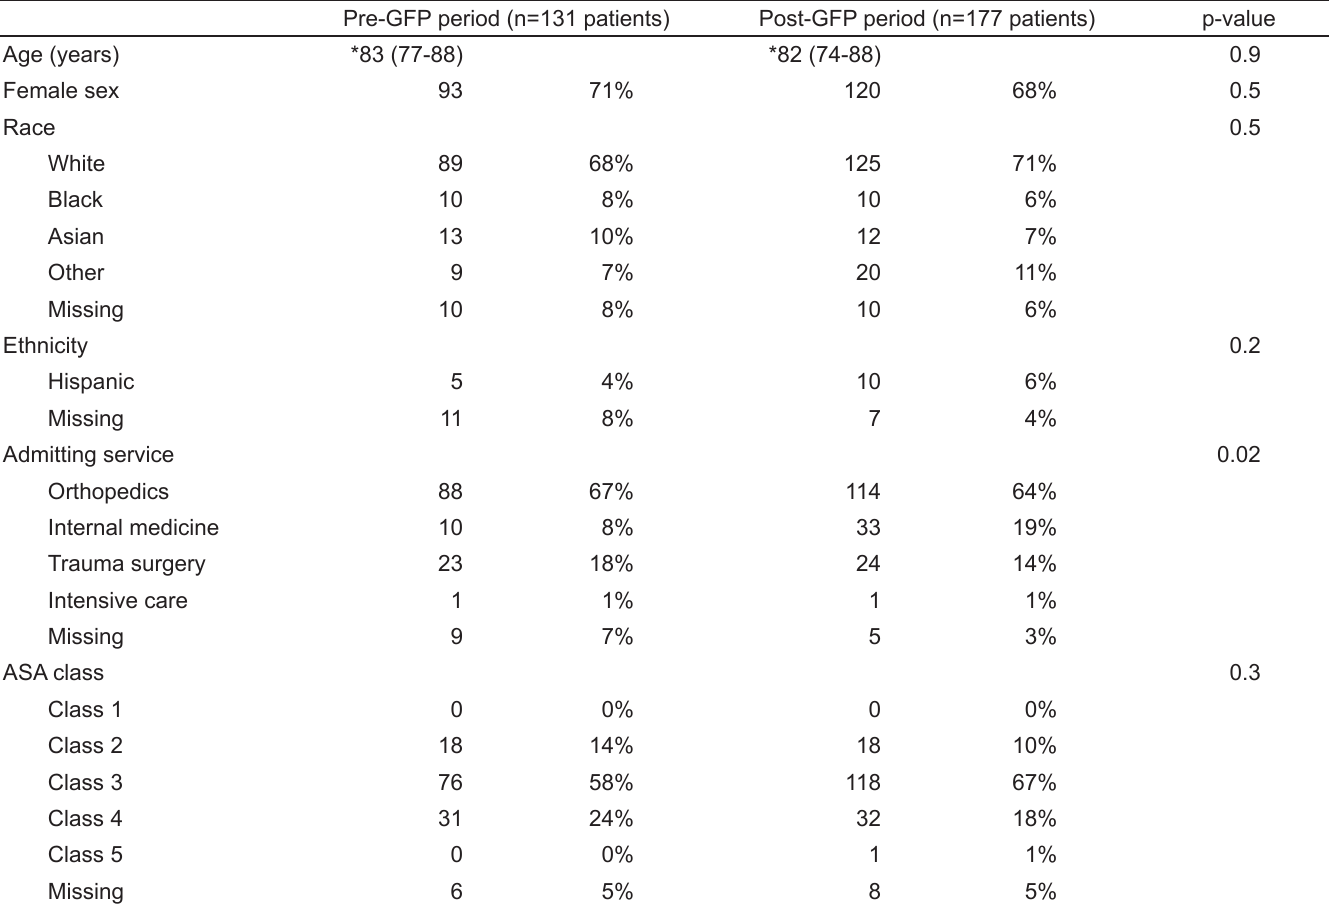
Table 1. Patient characteristics before and after implementation of a geriatric fracture program in the emergency department.